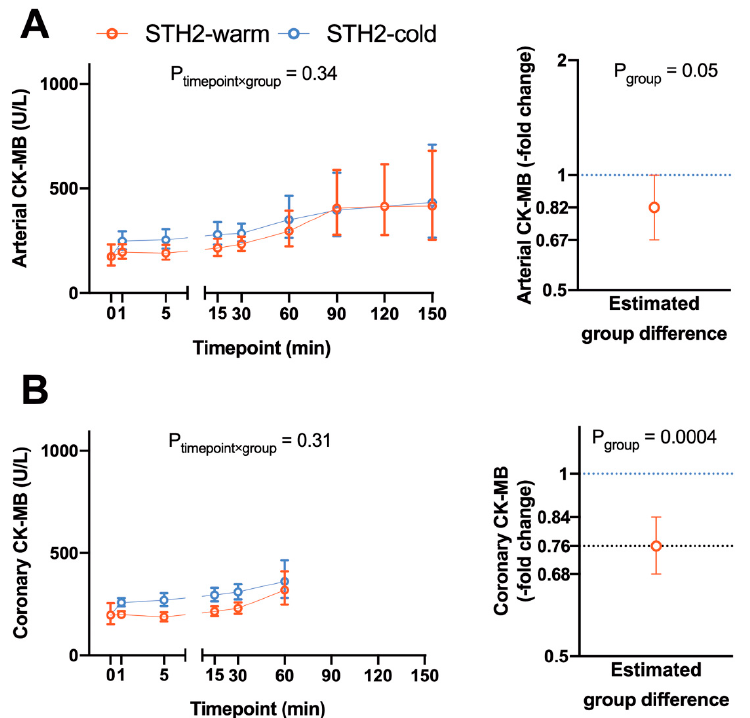
Figure 4. Levels of circulating creatine kinase during reperfusion. Arterial CK-MB ( A ) levels were generally lower (0.82-fold, 95% CI 0.67–1.00, p = 0.05) in pigs receiving warm STH2 cardioplegia compared to the cold STH2 group, whereby the di ff erences in arterial CK-MB levels were independent of the time course. CK-MB levels ( B ) measured in the coronary venous blood were also generally lower in pigs receiving warm STH2 cardioplegia (0.76-fold, 95% CI 0.68–0.84, p = 0.0004). Values are estimated geometric means (left) or estimated -fold di ff erences (right) with 95% confidence intervals, n = 5–6 / group. CK-MB: creatine kinase-myocardial